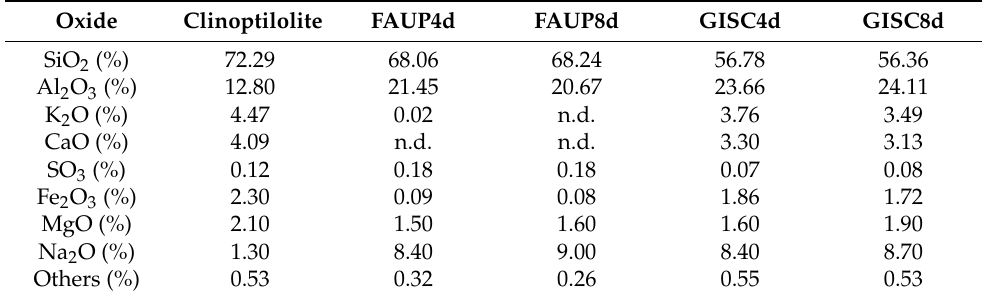
Table 2. Si/Al molar ratio values and synthesis yield of standard FAU zeolites and GIS zeolites from